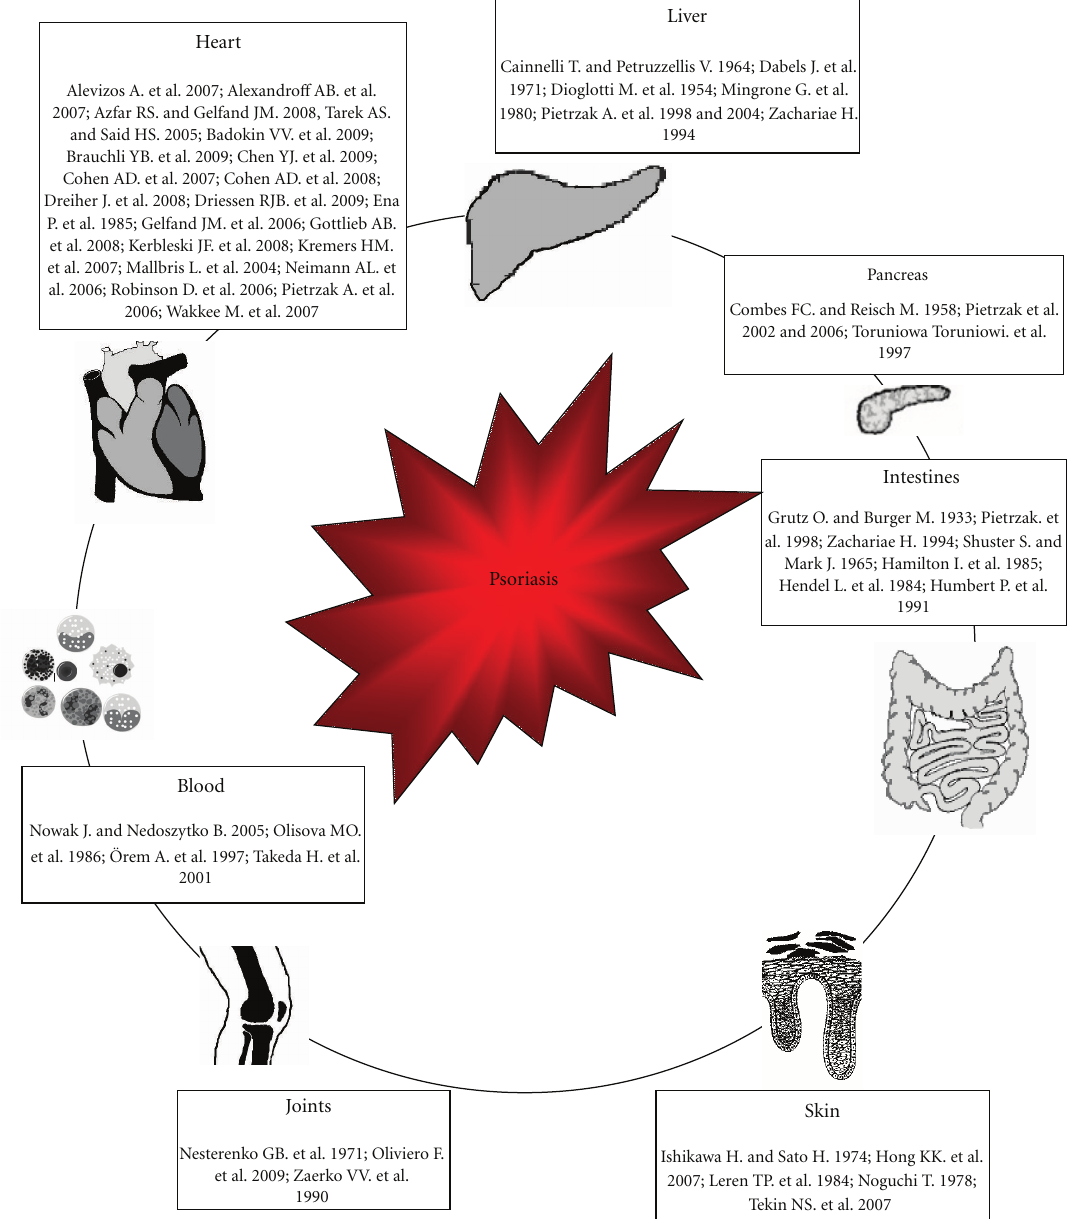
Figure 2: Influence of the psoriasis associated dyslipidemia on human organs. This figure is based (after permission) on the figure from